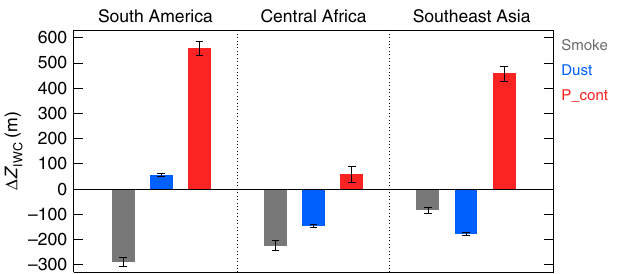
Fig. 2 Changes of cloud altitude in different aerosol environment. Annual average changes of the altitude centroid for deep convective clouds, computed as Z IWC differences between clean environment and different aerosol environments: smoke aerosol (gray), dust aerosol (blue) and polluted continental aerosol (red) over the three selected regions: (left) South America, (middle) Central Africa and (right) Southeast Asia. The error bars denote the standard errors of the Δ Z IWC